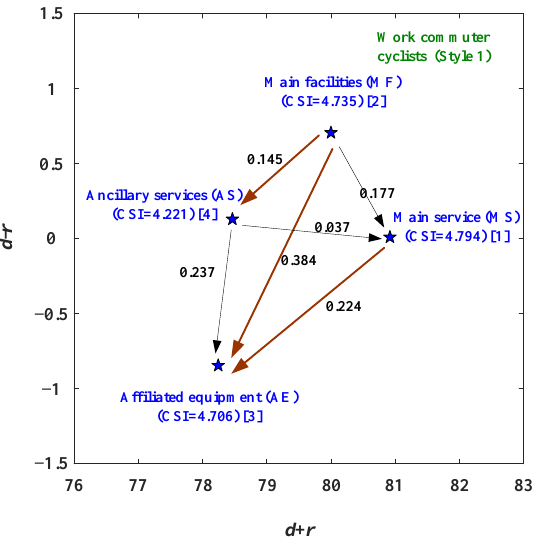
Figure 3. The adoption paths of work commuter cyclists (Style 1). Table 20. The adoption paths of users of work commuter cyclists (Style 1). Work Commuter Cyclists (Style 1)